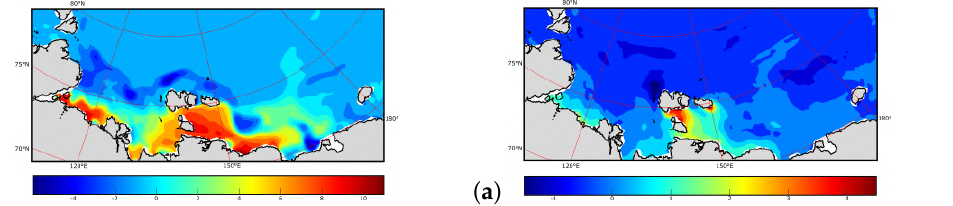
Figure 15. Sensitivity SST to fast ice parameterization: difference in monthly sea surface temperature SST(A1)-SST(A0) (in ◦ C) for July ( a ) and September ( b